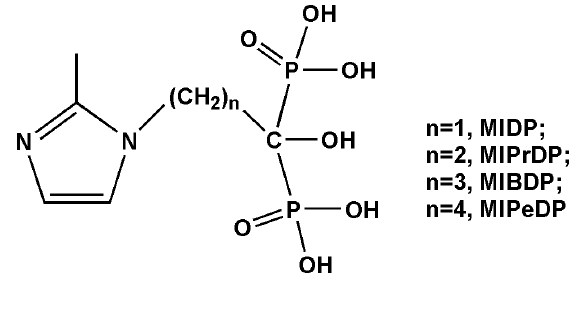
Figure 1. Structures of MIDP and its